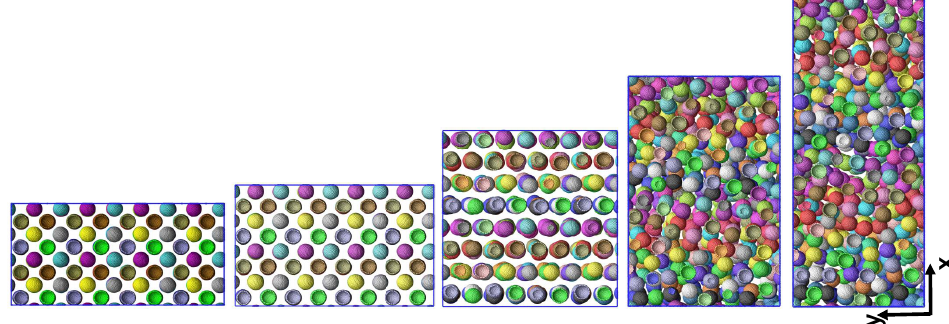
Figure 6. Snapshots (projections onto the x - y -plane) of the three-dimensional L2 • system with N = 200, ε r = 24, φ = 20.8%, subjected to uniaxial extension in x -direction at strain rate ˙ (cid:101) xx = 0.005, captured at different stretching strains of (cid:101) xx = 0, 18%, 70%, 120%, and 200% from top to bottom. These states are marked by colored bullets in Figure 5a,c. The NPs remain unstructured at strains larger than (cid:101) xx ≥ 200%. Polymers are not shown here for the sake of clarity. The corresponding NP–NP pair correlation functions at these strains are given in Figure